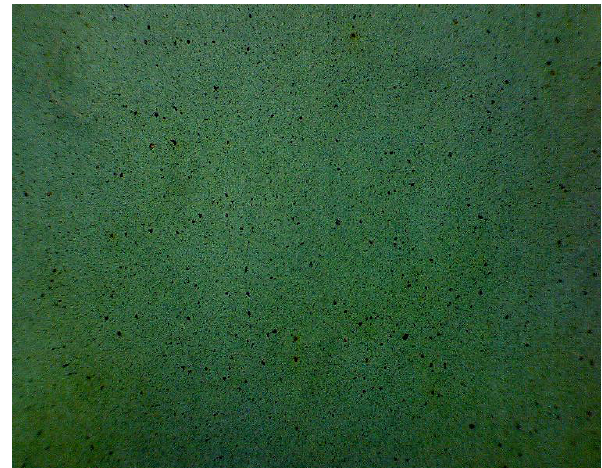
Figure 1. Image of distribution of iron particles in the PVA/iron film recorded with a DigiMicro 2.0 Scale Microscope camera, dnt GmbH (20 × magnification).